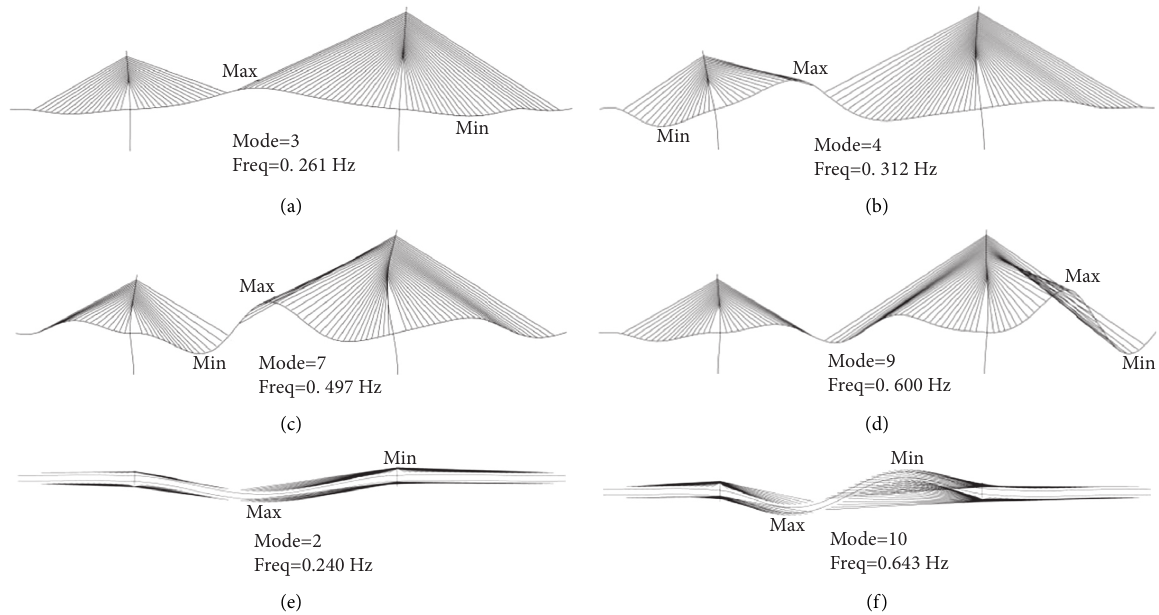
Figure 9: Key vibration mode of the bridge. (a) First-order vertical vibration mode ( f � 0.261 Hz). (b) Second-order vertical vibration mode ( f � 0.312Hz). (c) Third-order vertical vibration mode ( f � 0.497Hz). (d) Fourth-order vertical vibration mode ( f � 0.600Hz). (e) First-order lateral vibration mode ( f � 0.240Hz). (f) Second-order lateral vibration mode ( f � 0.643Hz).